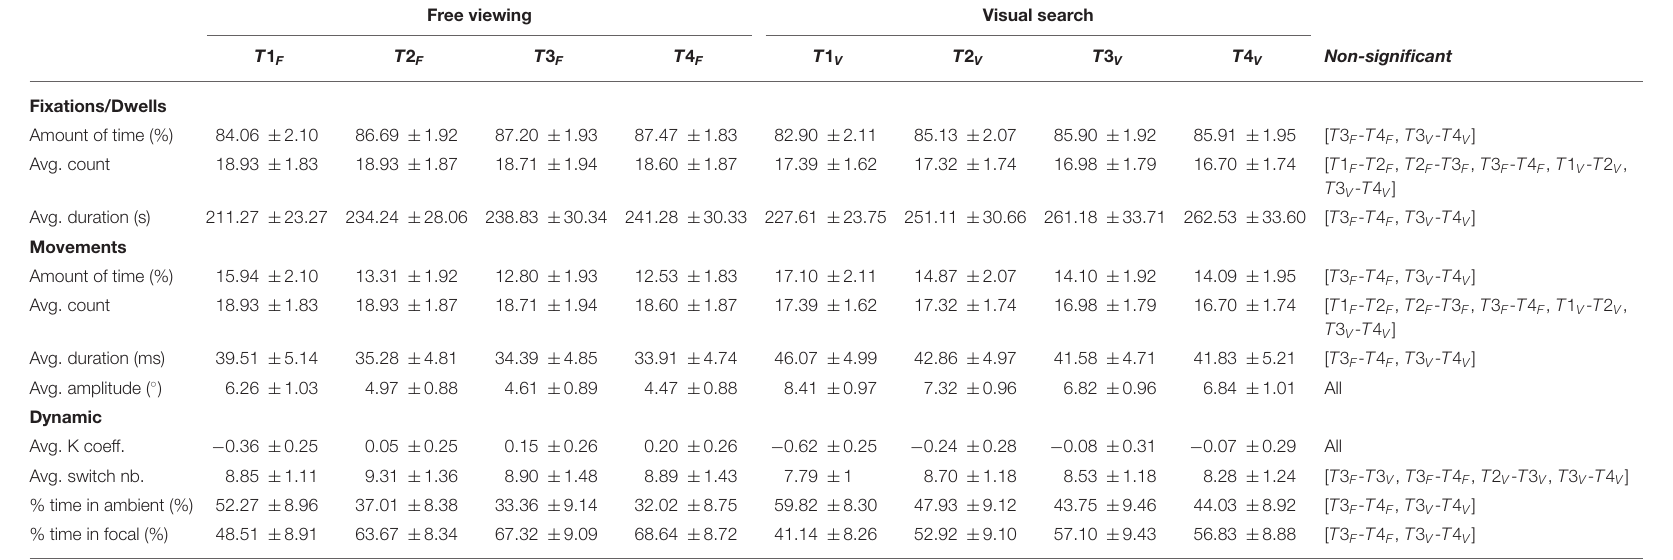
The non-significant column regroups all post-hoc with a p -value > 0.05. Not mentioned post-hocs have a p